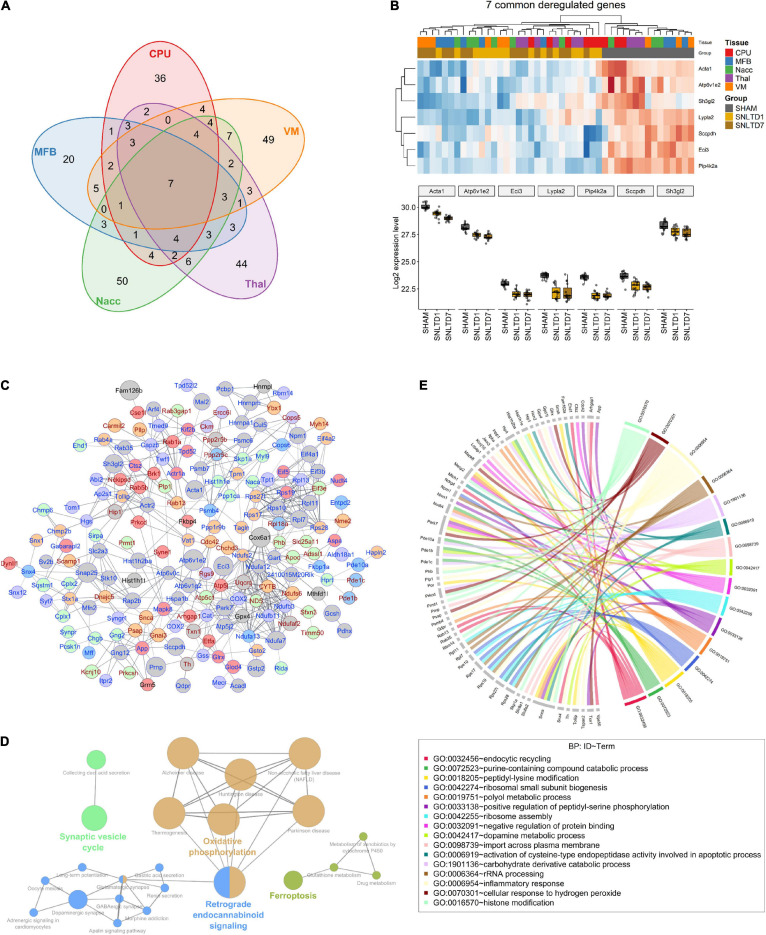
Commonly deregulated proteins across tissues. (A) Venn diagram resuming the intersections between deregulated proteins (both up- and dow-regulated) in CPu, MFB, NAcc, Thal, and VM. (B) Heatmap (upper) and boxplot (lower) showing the expression profile of the seven commonly deregulated proteins in all tissues. (C) String-db interaction network of 183 deregulated proteins. Nodes colored in red, blue, green, purple, and orange represent CPu, MFB, NAcc, Thal, and VM-specific proteins, respectively. Gray nodes represent proteins deregulated in more than one tissue. Node size is proportional to the number of tissues in which the correspondent protein is deregulated. Symbols for proteins that are consistently up-regulated at days 1 and 7, compared to sham, are annotated in red, whereas those for consistently down-regulated proteins are annotated in blue. Edge width is proportional to interaction score according to string-db. Only interactions with a score above 0.6 were shown. (D) Network of KEGG pathways that are enriched in commonly deregulated genes. Nodes representing interconnected pathways are filled with the same color. (E) Circos plot showing Gene Ontology (GO) for biological processes (BP) that were significantly deregulated in the dataset.